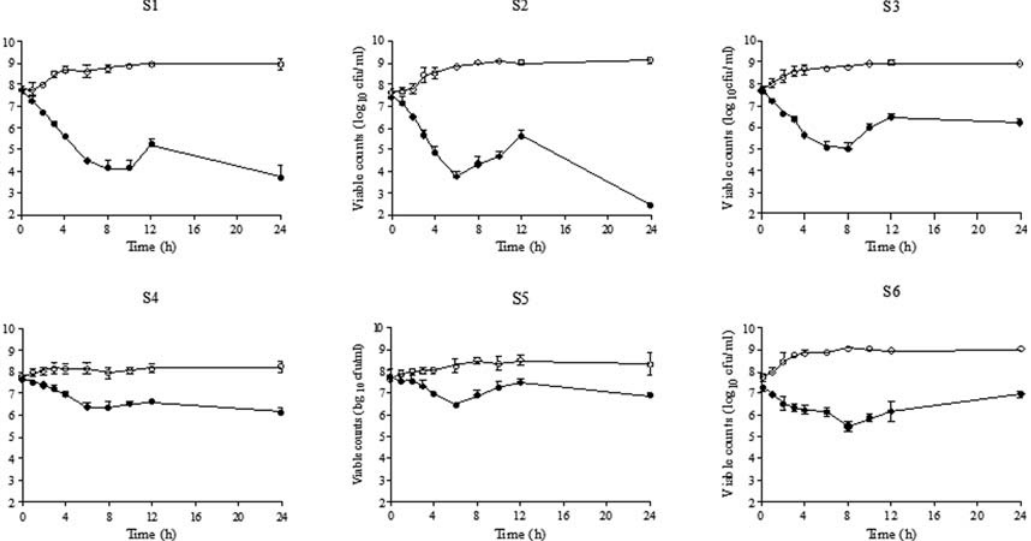
Figure 2. Cefditoren antibacterial activity over time: Mean bacterial counts over 24h in antibiotic-free (open circles) and cefditoren (black circles) simulations.